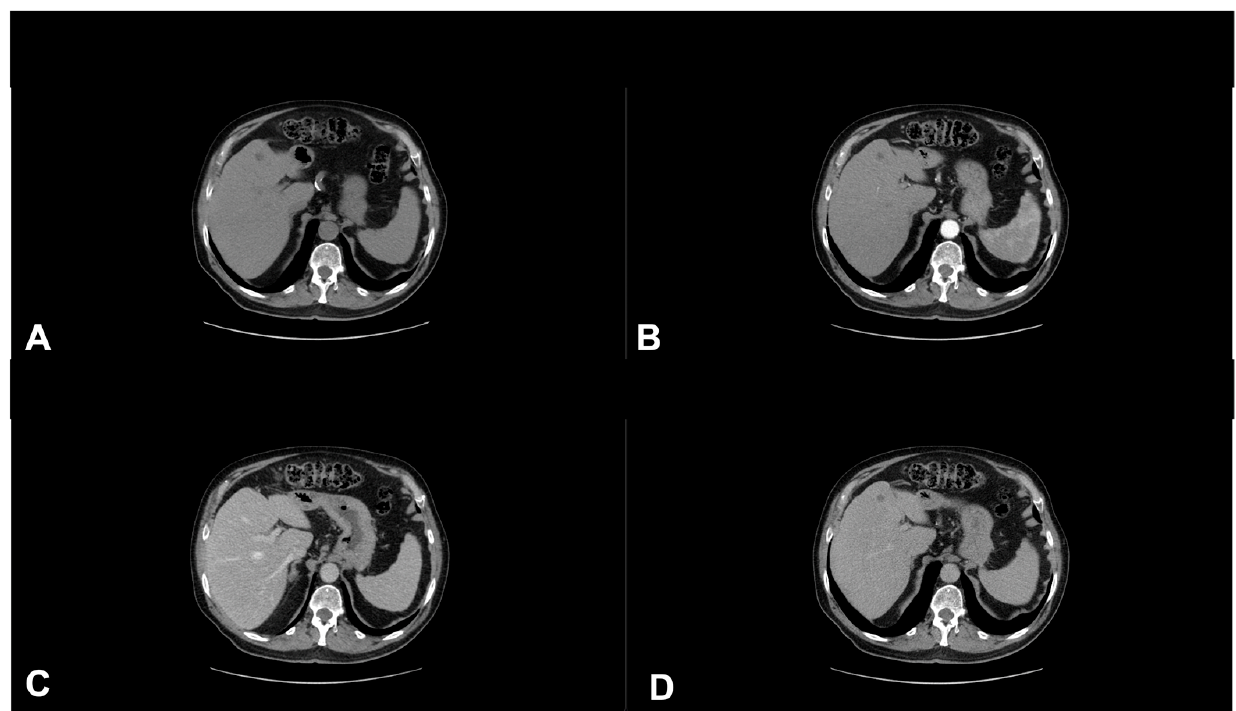
Figure 12. Enhanced CT imaging (128 slices) of the previous patient performed in March 2022. Non enhanced CT ( A ), Arterial phase ( B ), Portal phase ( C ), Tardive phase ( D ). The metastatic lesions were no longer present, pseudo progression.